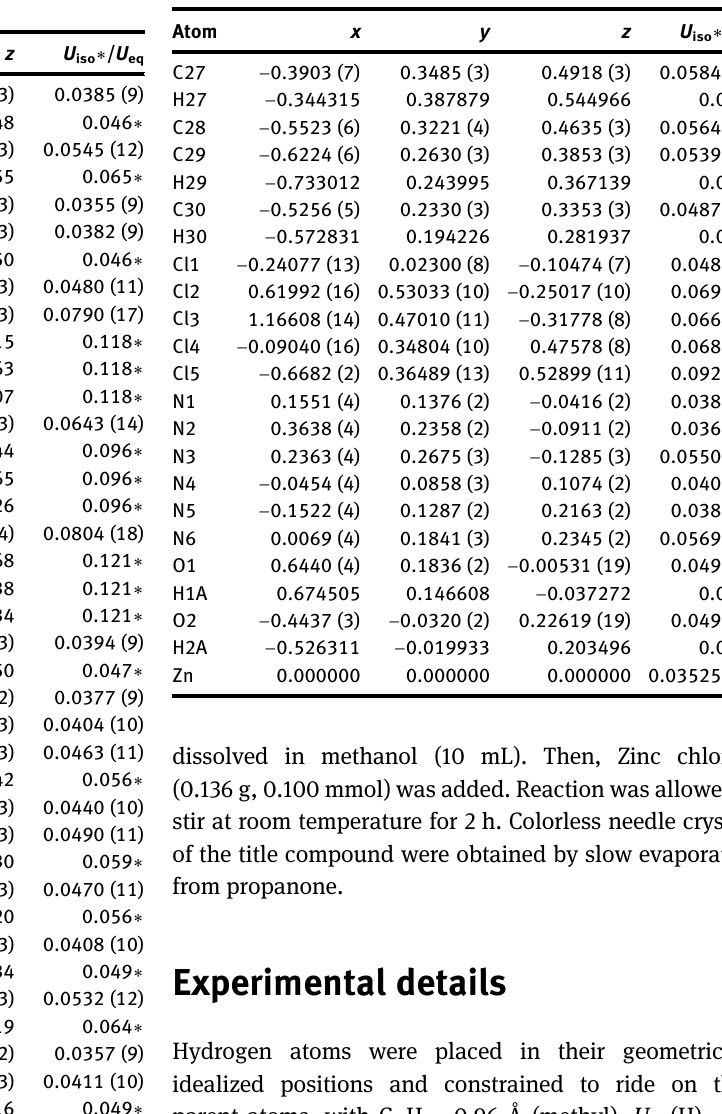
Table  : Fractional atomic coordinates and isotropic or equivalent isotropic displacement parameters (Å 